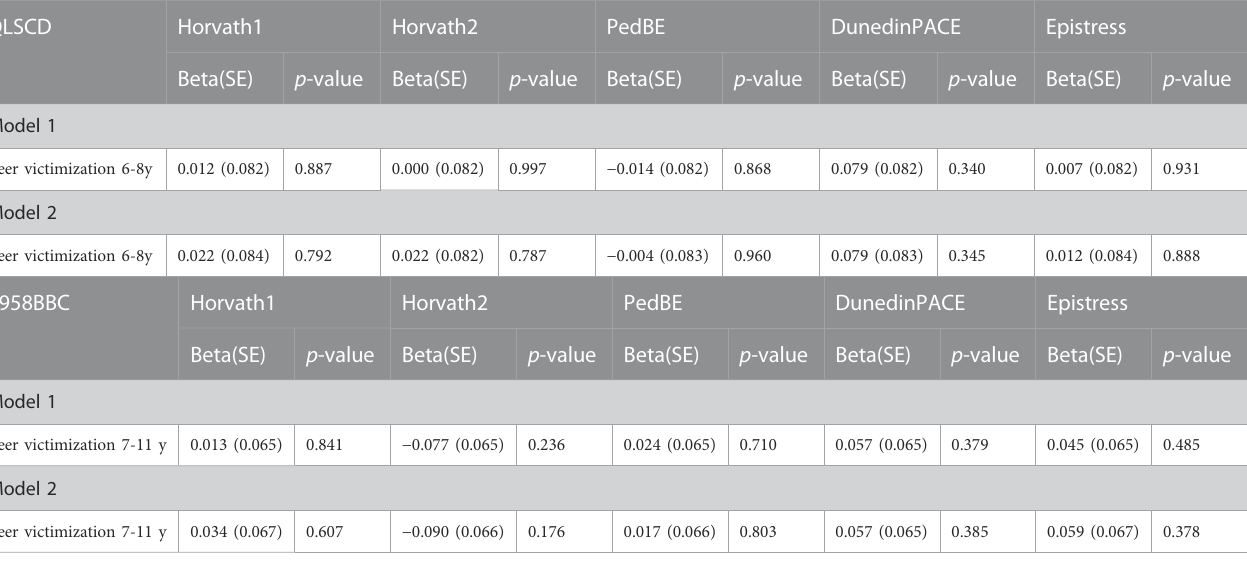
TABLE 3 Linear regressions between epigenetic residuals and peer